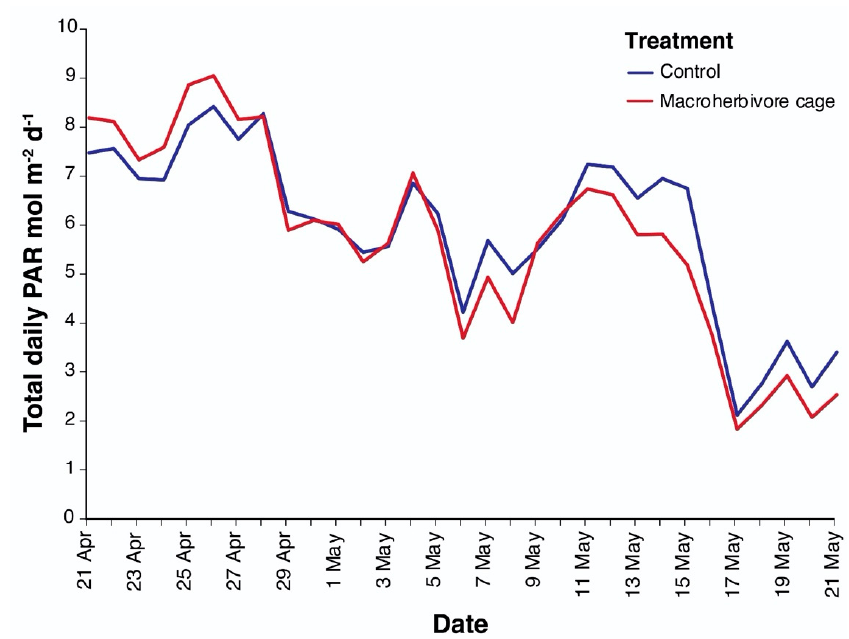
Figure A1. Total daily light in control and macroherbivore cage plot.